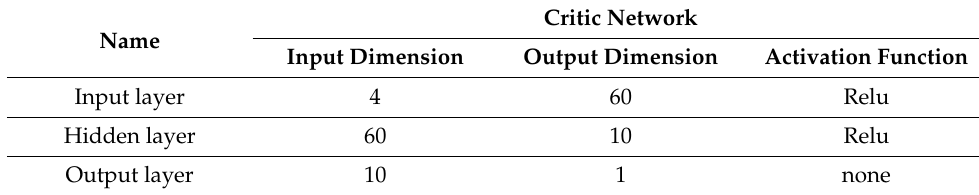
Table 2. Critic network structure.